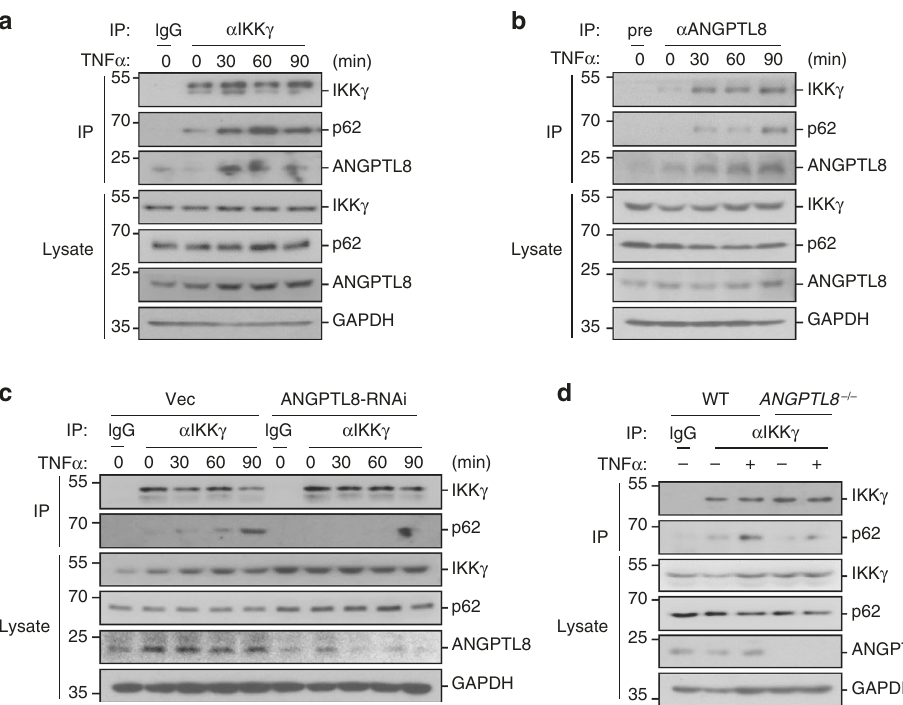
Fig. 8 ANGPTL8 is important for the IKK γ -p62 interaction. a , b ANGPTL8 forms a complex with IKK γ and p62 upon TNF α stimulation. HepG2 cells were stimulated with TNF α or left unstimulated for indicated time (2.5 × 10 7 cells per group). And then cells were lysed and cell lysate was subjected to co-IP analysis by anti-IKK γ . ( a ) or anti-ANGPTL8 ( b ) followed immunoblots. c The effects of ANGPTL8-RNAi on the IKK γ -related protein complex formation. The experiment was performed as in a except the ANGTPL8-RNAi or control cells (2.5 × 10 7 ) were used. d The effects of ANGPTL8 de fi ciency on the IKK γ - related protein complex formation. ANGPTL8-de fi cient or control cells (2.5 × 10 7 ) were left untreated or treated with TNF α for 1 h before subjected to Co- IP analysis and immunoblots. Data are representative of three independent